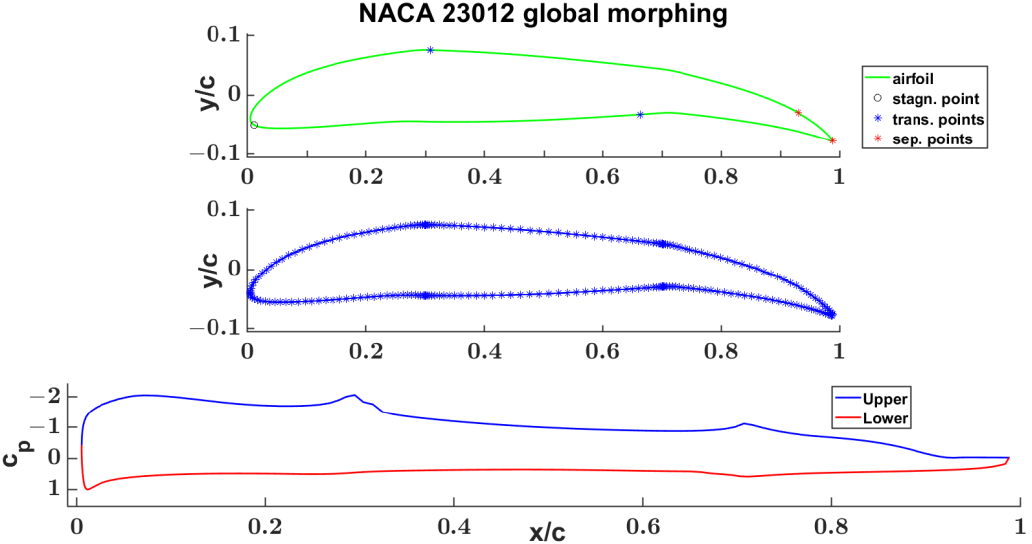
Figure 30. Morphed NACA 23012 airfoil—segment Chebyshev discretization—Cp(x) at Re 3.5 × 10 6 , and 𝛼 = 4°; 4° and − 15° rotations at the LE and TE, respectively